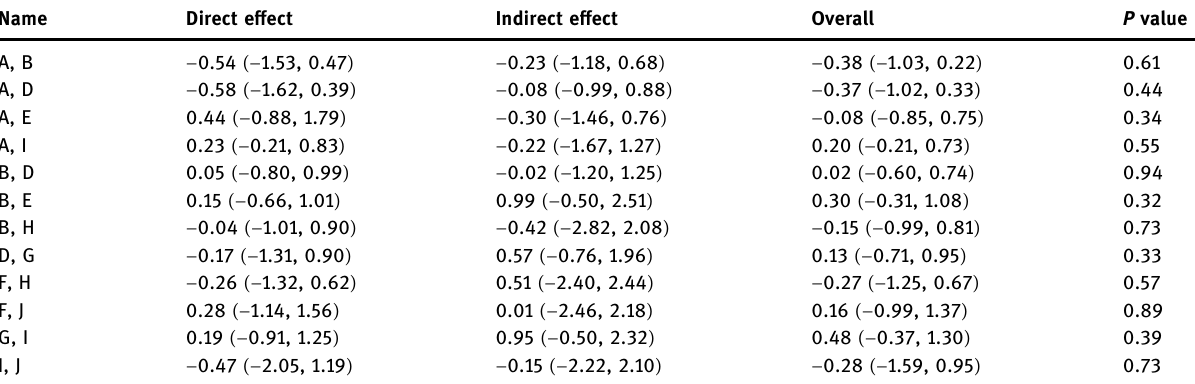
Table 2: Inconsistency test of direct and indirect pairwise comparisons of six treatment modalities under six end point outcomes